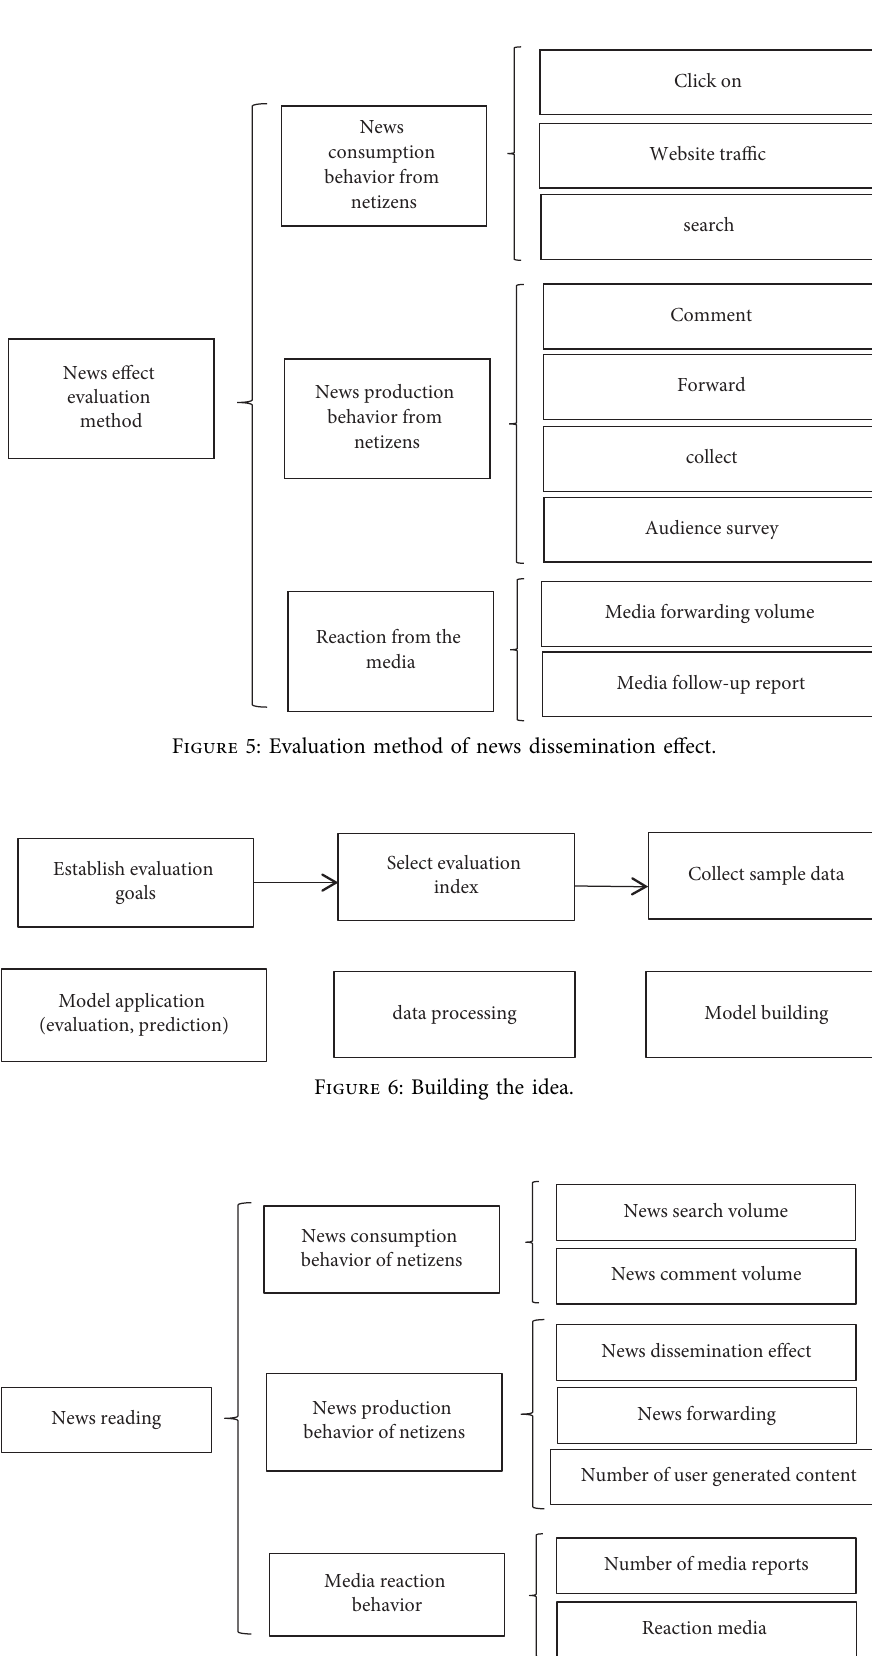
Figure 7: Selection of evaluation